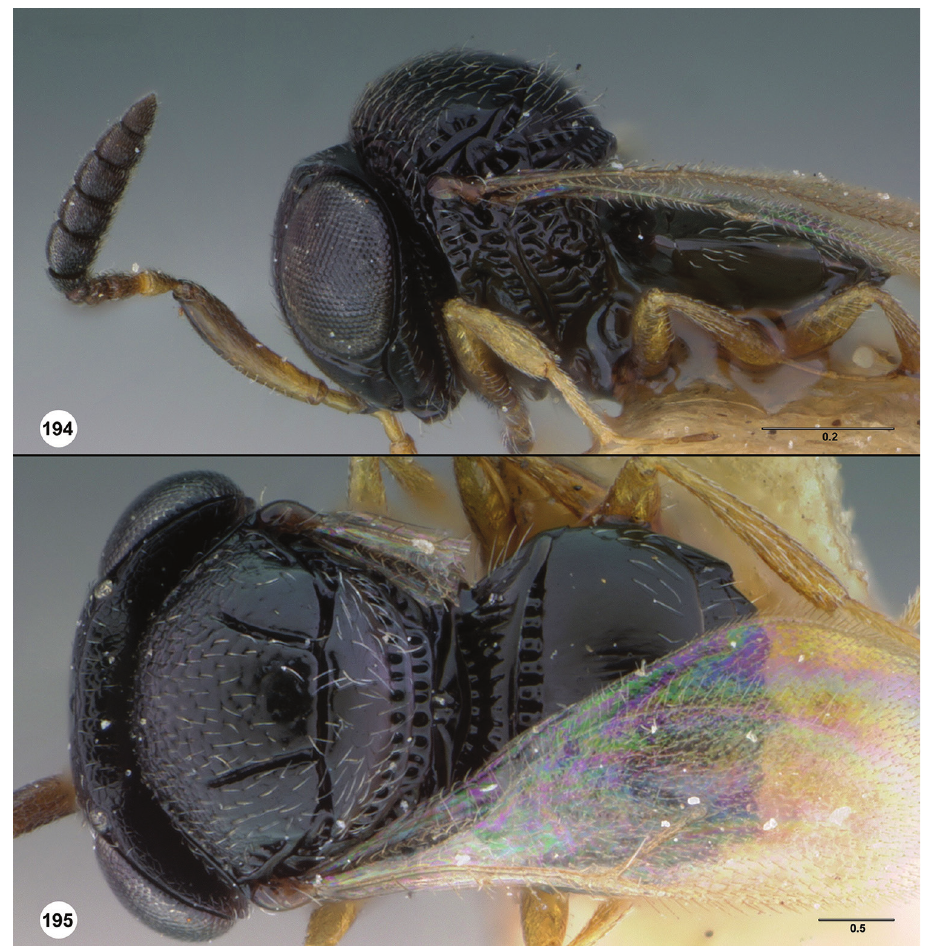
Figures 194–195. Trissolcus trophonius , female holotype (B.M. TYPE HYM. 9.315) 194 head, meso- soma, metasoma, lateral view 195 head, mesosoma, metasoma, dorsal view. Scale bars in millimeters. on A7: 2. Facial striae: absent. Number of clypeal setae: 4. Microsculpture on gena di- rectly above mandibular condyle: absent. Shape of ventral gena in lateral view: narrow. Genal carina: absent. Malar striae: absent. Sculpture of malar sulcus: smooth. Orbital furrow: expanding in size ventrally, strongly so at intersection with malar sulcus. Mac- rosculpture of frons between antennal scrobe and anterior ocellus: absent. Preocellar pit: present. Setation of lateral frons: sparse. Punctation of lateral frons: absent. Sculp- ture directly ventral to preocellar pit: dorsoventrally fluted. Macrosculpture of lateral frons: weakly horizontally striate, striae of antennal scrobe extending to lateral frons. OOL: separated by less than one ocellar diameter. Hyperoccipital carina: complete. Macrosculpture of posterior vertex: absent. Microsculpture on posterior vertex along occipital carina: absent. Anterior margin of occipital carina: coarsely